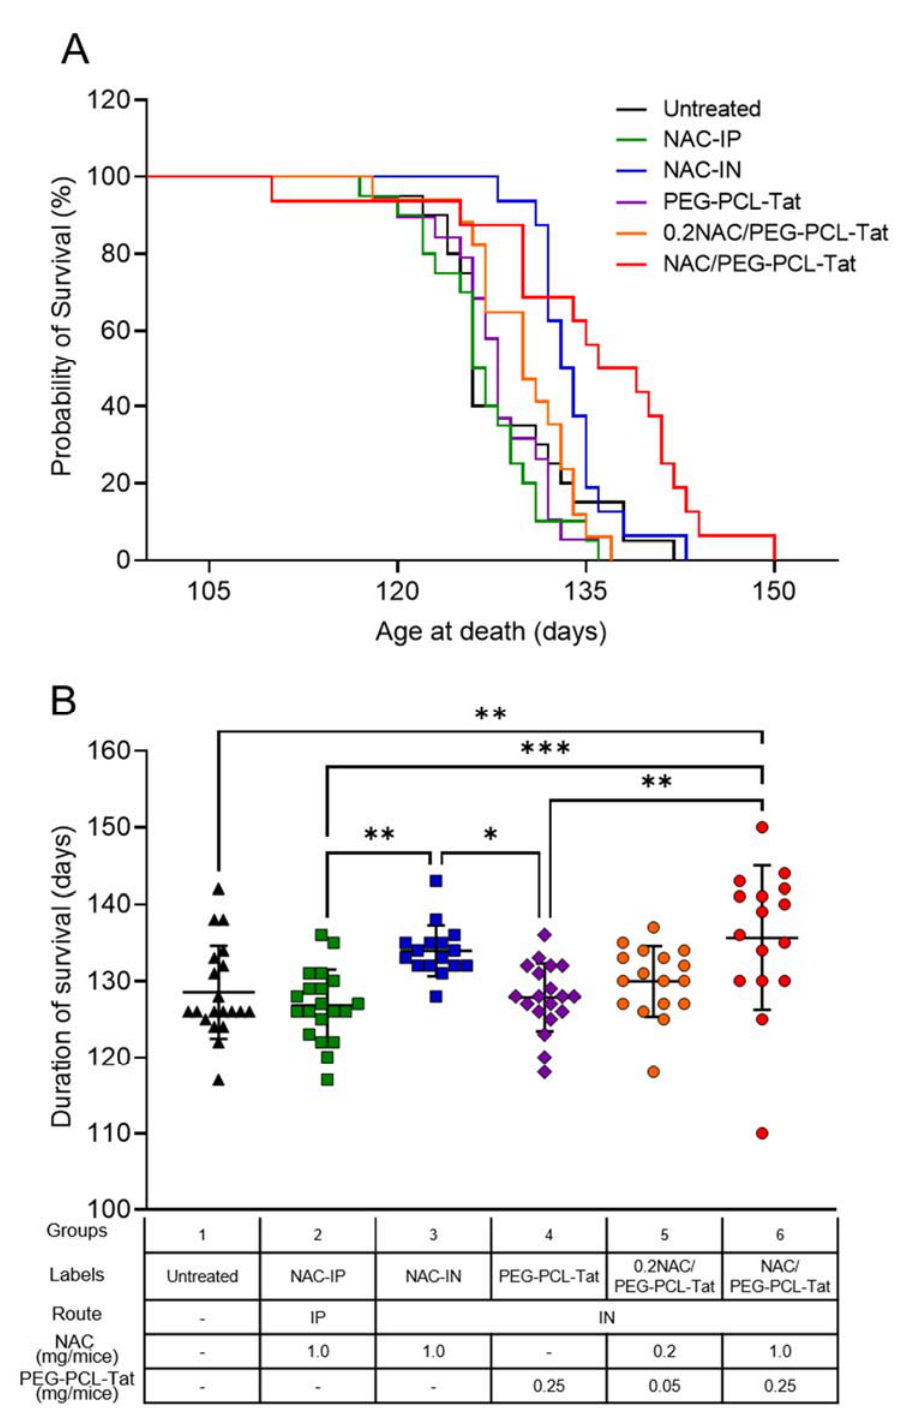
Figure 1. Lifespan of G93A mice treated with intranasal administration of NAC/PEG-PCL-Tat. G93A mice were treated with NAC-IP (1 mg), NAC-IN (1 mg), PEG-PCL-Tat (IN), 0.2NAC/PEG-PCL-Tat (IN; 0.2 mg), or NAC/PEG-PCL-Tat (IN; 1 mg), starting at a late symptomatic stage (15 weeks old). ( A ) Survival curves were analyzed using Kaplan–Meier survival analysis with the log-rank test; ( B ) The graph shows the lifespan comparative result. The values are presented as mean ± SD. Statistical significance was determined using one-way ANOVA followed by Tukey’s post hoc test. * p < 0.05, ** p < 0.01, and *** p <